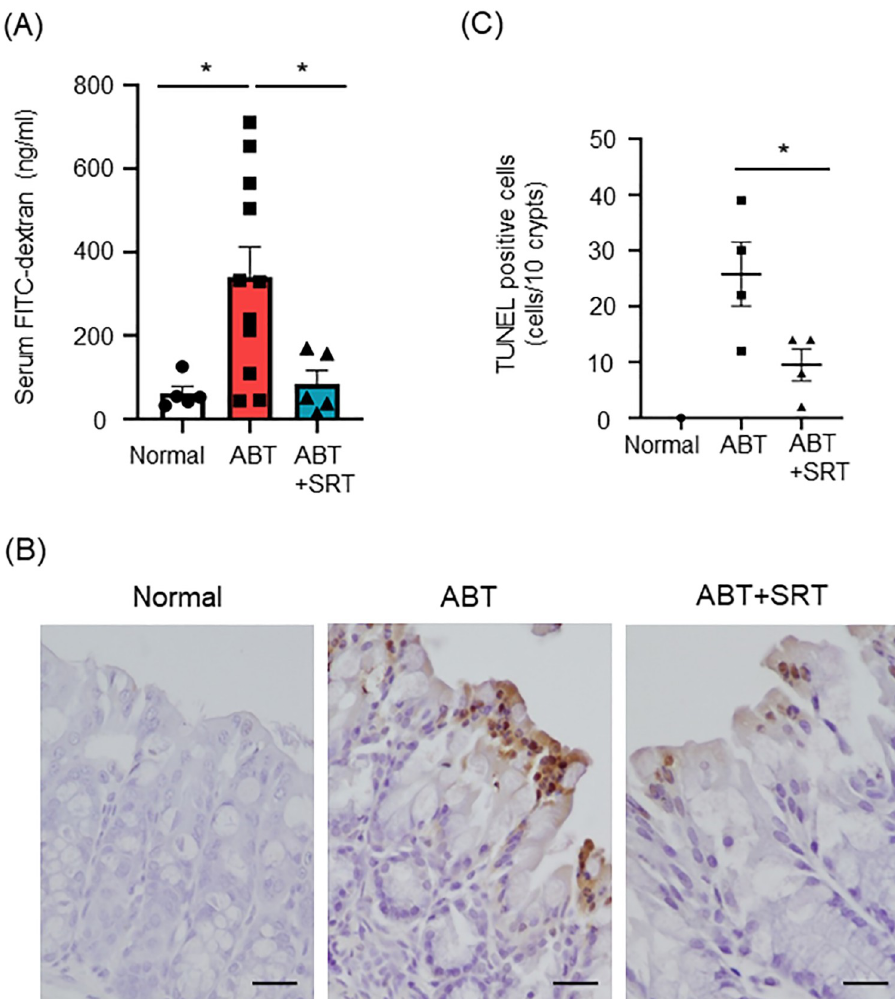
Fig 3. Effect of Saireito on antibiotic-induced colonic epithelial barrier dysfunction and cell apoptosis in the colon. Normal group mice were given a normal diet and normal drinking water; ABT group mice were given a normal diet and A + V solution in drinking water for the last 7 days; ABT + SRT group mice were fed a 1.5% Saireito diet until the last day and given A + V solution in drinking water for the last 7 days. (A) Graph shows FITC-dextran levels in the serum of each mouse. One representative of two independent experiments (n = 5, normal group. n = 11, ABT group and n = 5, ABT + SRT group). (B) Graph shows TUNEL staining of the colon ( × 400). (C) Graph shows the number of TUNEL positive apoptotic cells in each section (n = 4, each group). Data were analyzed by one-way ANOVA followed by Tukey’s multiple comparisons test and student t test. Data are shown as mean ± SEM. � P < 0.05.